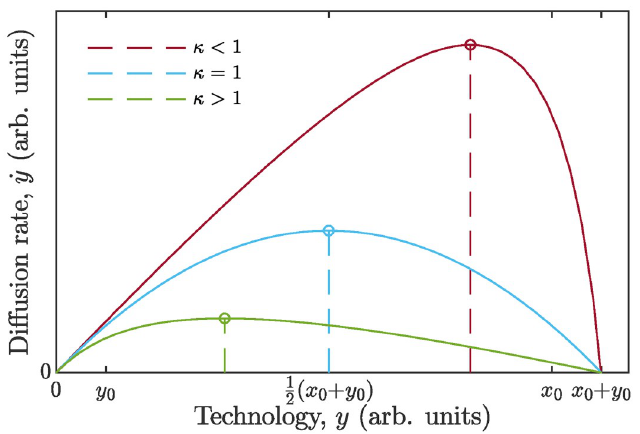
Fig 3. Diffusion curves, generated by model (21), in the plane ð y ; _ y Þ . The value of y , which delivers zero to d _ y = d y , corresponds to the inflection point (indicated by dashed line) in the domain of admissible values. The curves are right- skewed for ϰ > 1, and left-skewed for ϰ < 1. The case ϰ = 1 features a logistic growth curve.